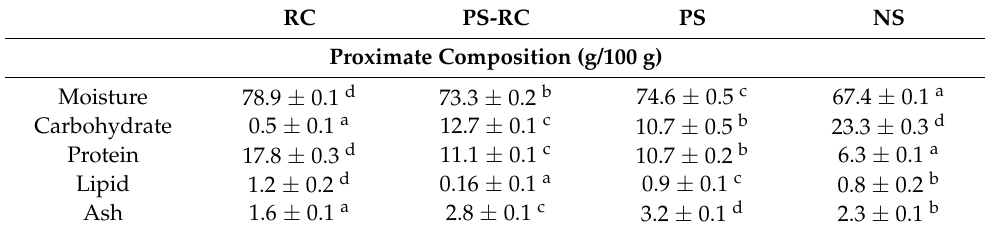
Table 1. Proximate composition of snow crab leg meat and commercial imitation crab sticks.